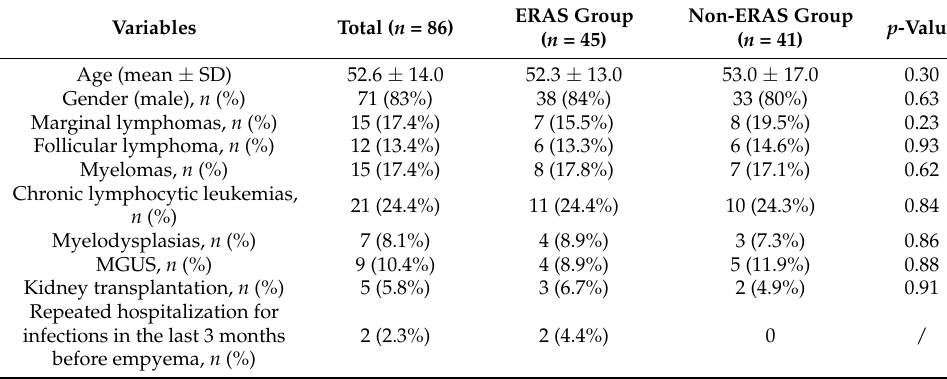
Table 2. Demographics and pre-operative